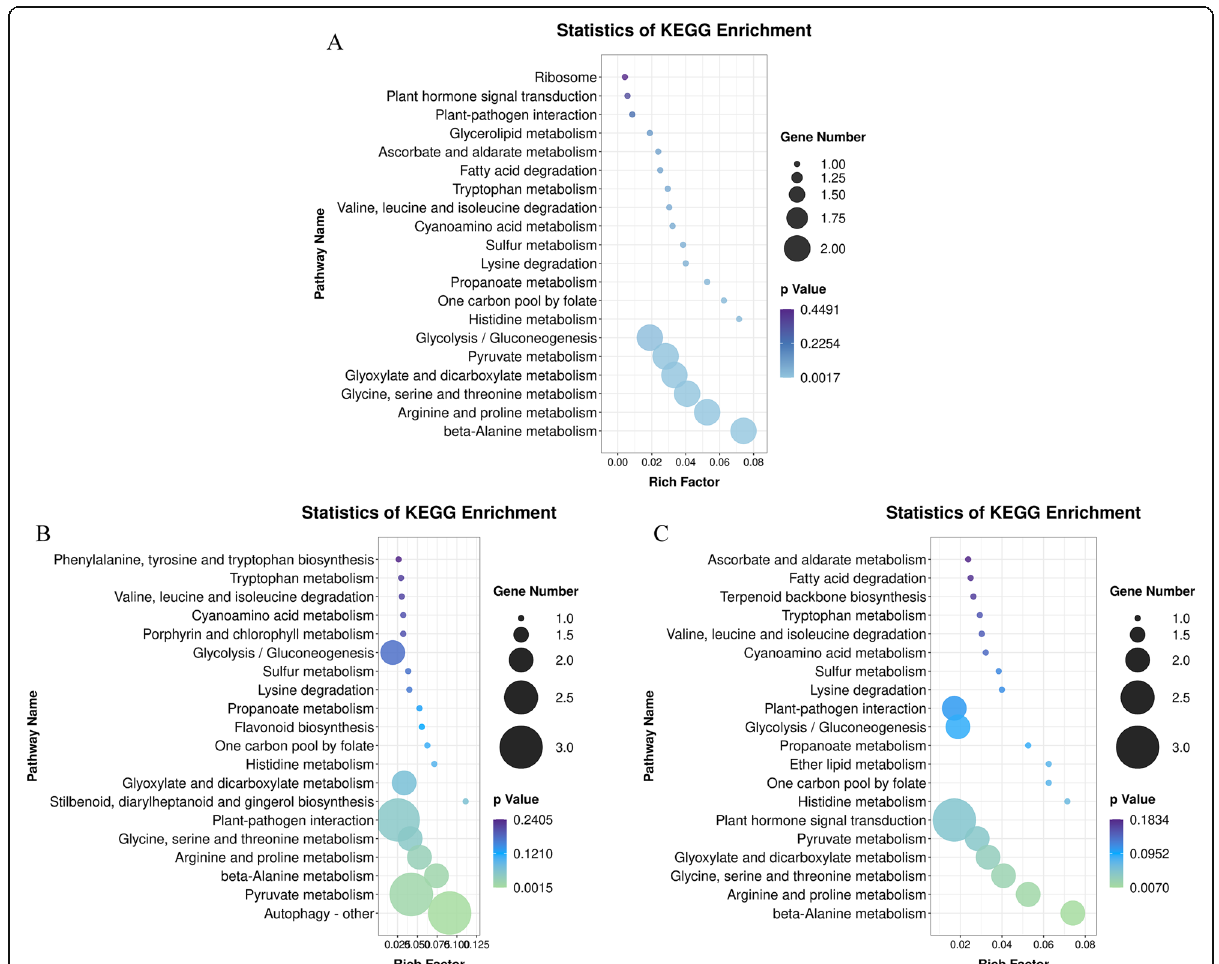
Fig. 8 The KEGG terms of differential m 6 A methylation genes in cv. NIP and cv. 9311. ( A ) the KEGG terms of common genes with differential m 6 A methylation in indica and japonica under cadmium stress ( B ) the KEGG terms of unique genes with differential m 6 A peaks in indica ( C ) the KEGG terms of unique genes with differential m 6 A peaks in